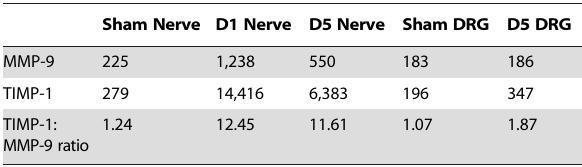
Table 2. TIMP-1: MMP-9 ratio in the nerve